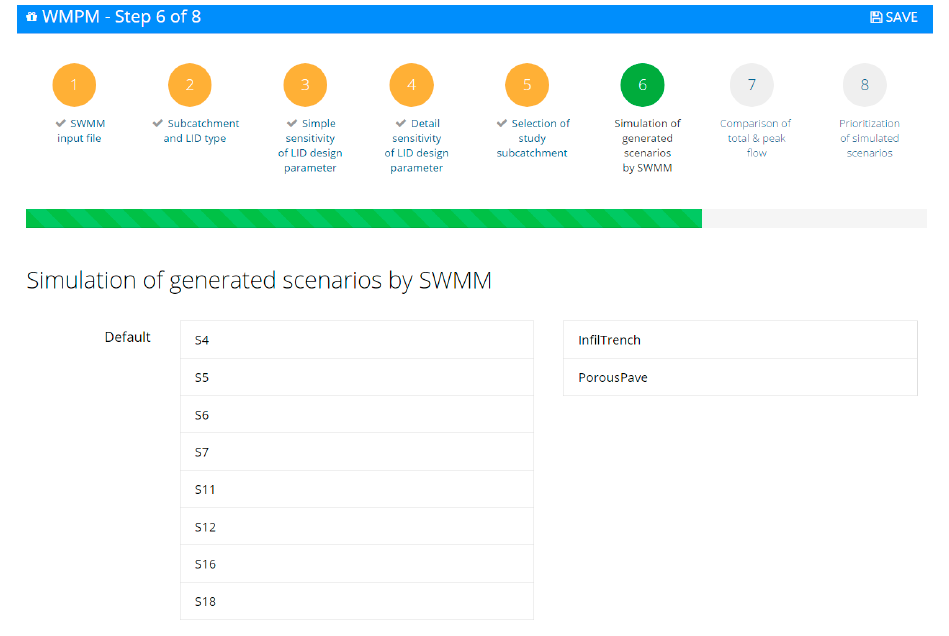
Figure 3. Screenshot of the 6th step of WMPM: generation and simulation of scenarios.